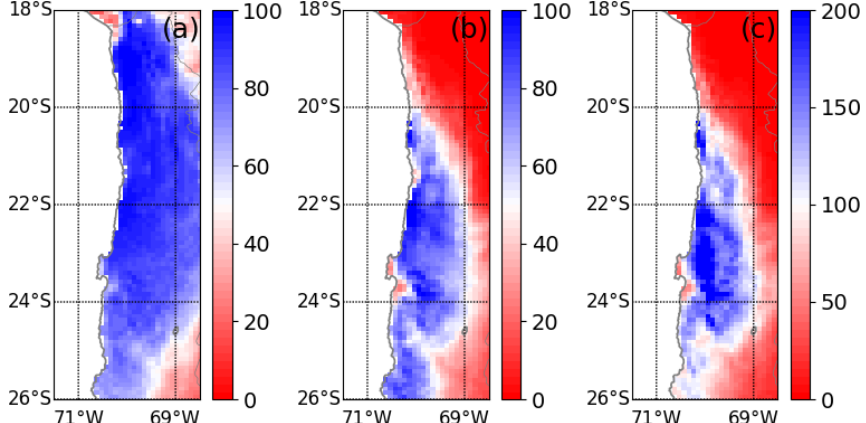
Figure 10. Fraction (in %) of the rainfall associated with MCB cluster 4 and 6 of WRF mP to (a) total winter rainfall in WRF mP , (b) total annual rainfall in WRF mP and (c) total annual rainfall in WRF hist (inner model domain with 10km resolution).